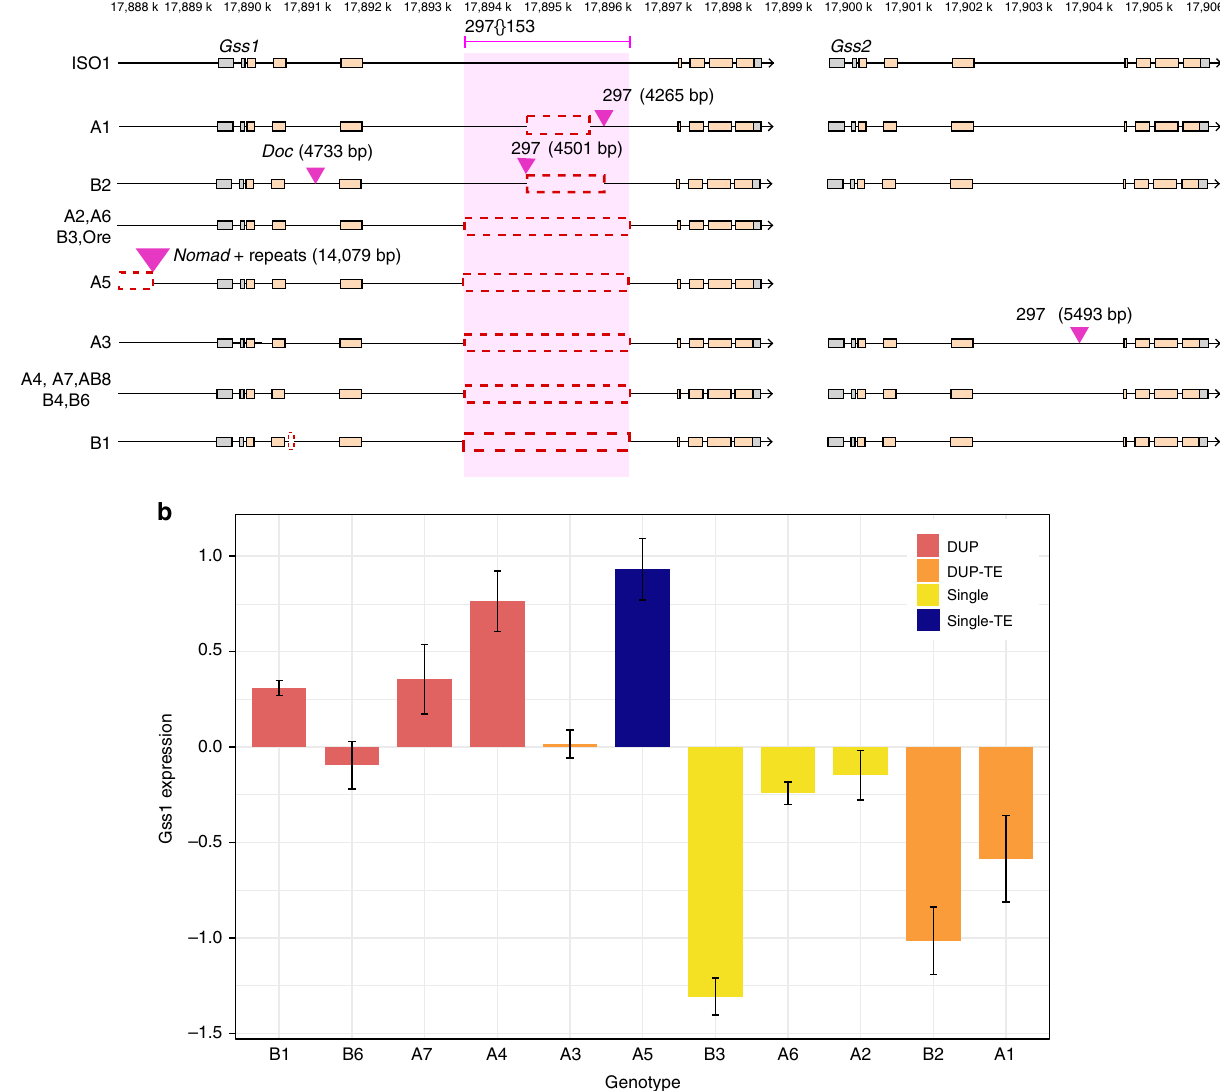
Fig. 5 SV allelic heterogeneity at a arsenic toxicity resistance candidate Gss1 and Gss2 . a Structurally distinct alleles at Glutathione synthetase ( Gss ) locus. Nine founder alleles consist of duplication of Gss , among which four also carries insertion of the LTR retrotransposon 297. Among the fi ve single Gss copy alleles, A5 possess a 14 Kb insertion comprising Nomad LTR TE fragments and simple repeats located 1064 bp 5 ′ to the transcription start site of Gss1. A5 also carries a deletion that removes 3489 bp (X:17,884,993-17,888,482) from the 5 ′ upstream region of Gss1 . b Normalized expression level of Gss1 for different founder genotypes. All founder alleles, except A5, possessing single copy Gss show varying levels of downregulated transcript levels. We hypothesize that the indel upstream of the Gss1 transcription start site (TSS) in A5 up-regulates expression. Error bars represent standard errors of the genotypic